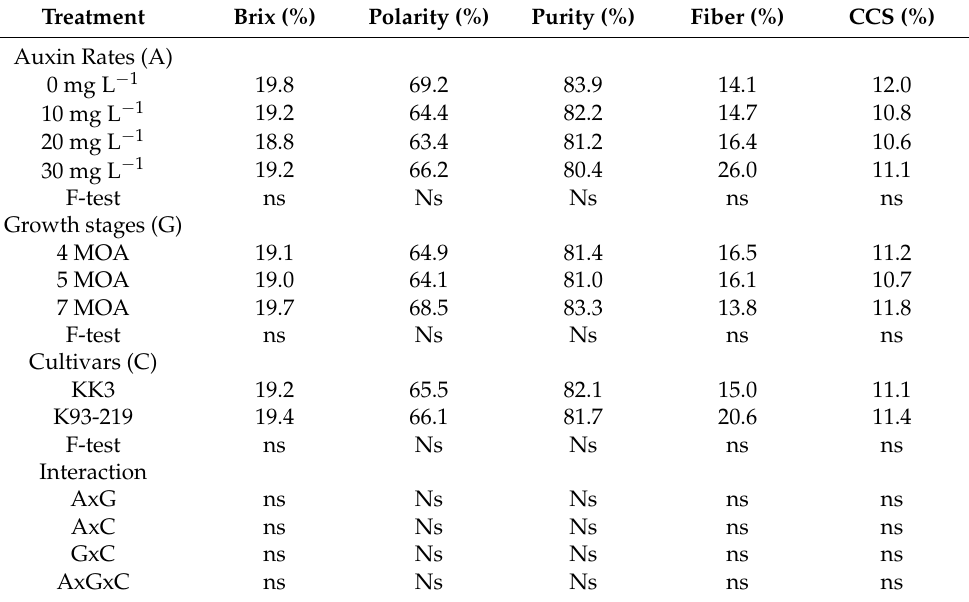
Table 11. Sugar quality components of two sugarcane cultivars as affected by auxin application rates at different growth stages at harvest, Experiment